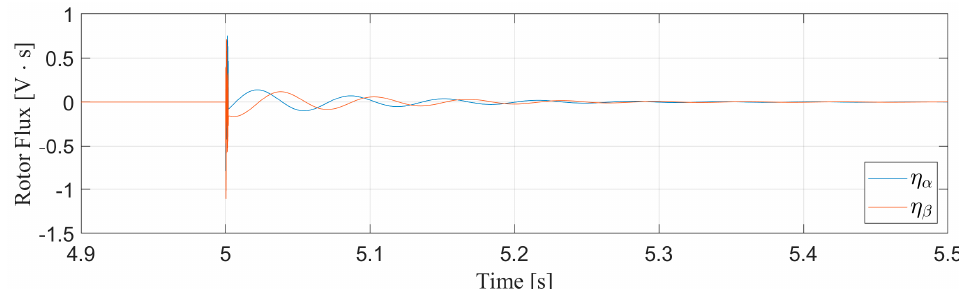
Figure 8. Flux error during wind step.